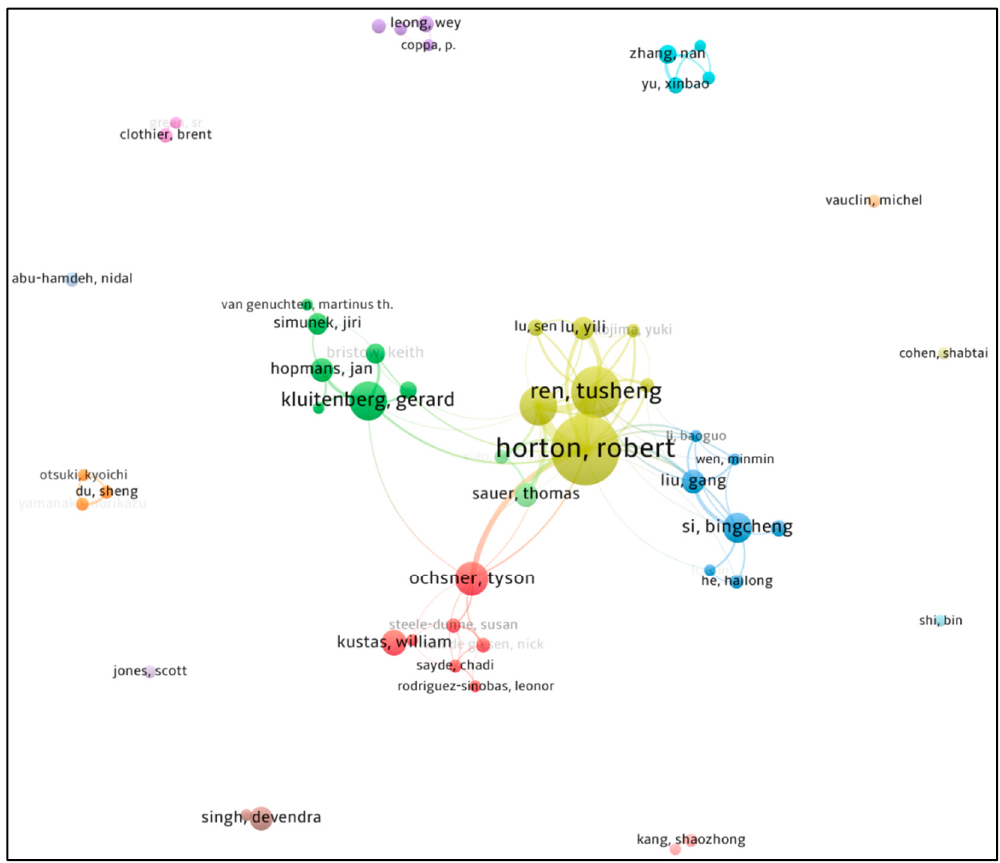
Figure 2. Co-authorship network map of authors with a threshold of five publications per author and maximum 25 authors per publication (produced with the VOSviewer). There are 16 clusters (closely worked group) with a total links of 95 and total link strength (TLS) of 429. Researchers in the co-authorship network are linked to each other based on the number of publications they have authored jointly. The nodes (circles) and font in larger size indicate more publications and the thicker line indicates a stronger collaboration between researchers. Note that some labels were not shown in the figure because of overlap (e.g., label of Dr. Joshua Heitman was overlapped by the label of Dr. Tusheng Ren), while the labels in grey were assigned by the VOSviewer to avoid label overlap. The font size and capitalization cannot be adjusted in the VOSviewer.